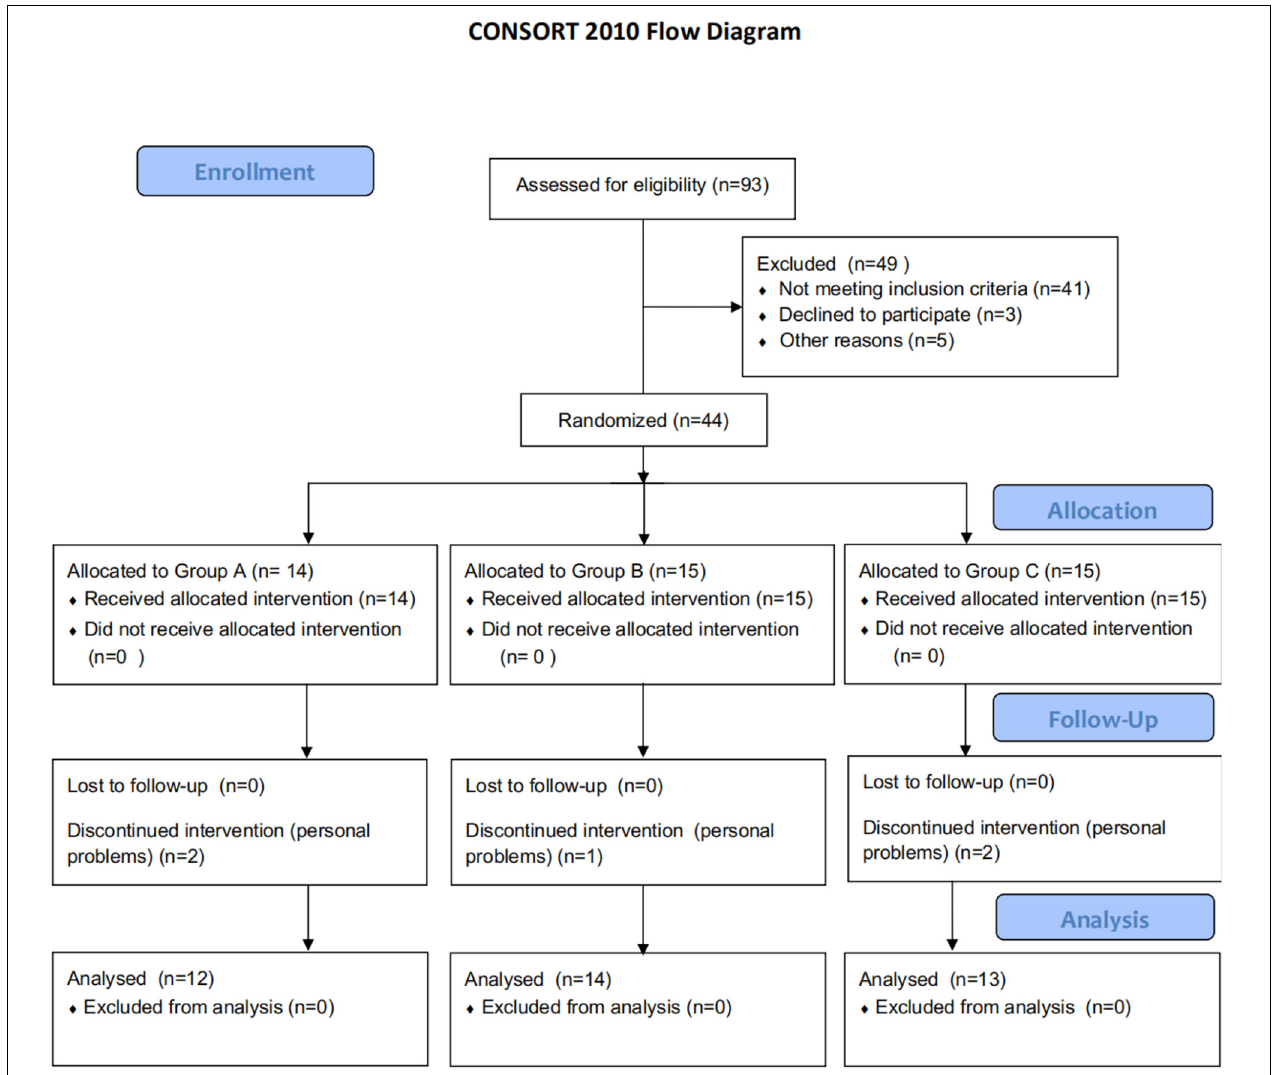
FIGURE 1 | Flowchart of the trial. Group A: high-frequency rTMS during hand grip training; Group B: high-frequency rTMS alone; Group C: hand grip training alone; rTMS: repetitive transcranial magnetic stimulation. CONSORT flow diagram illustrates recruitments, group allocation, follow-up, and